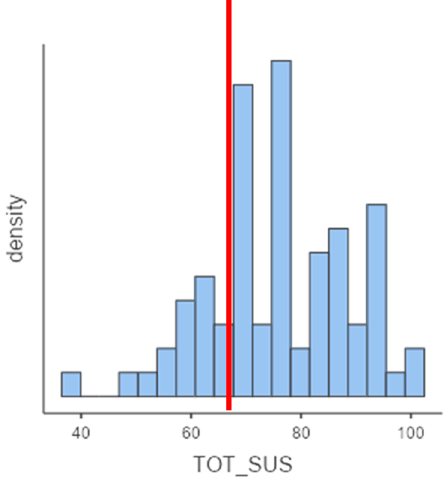
Figure 3. Graphic representation of the adjective rating.